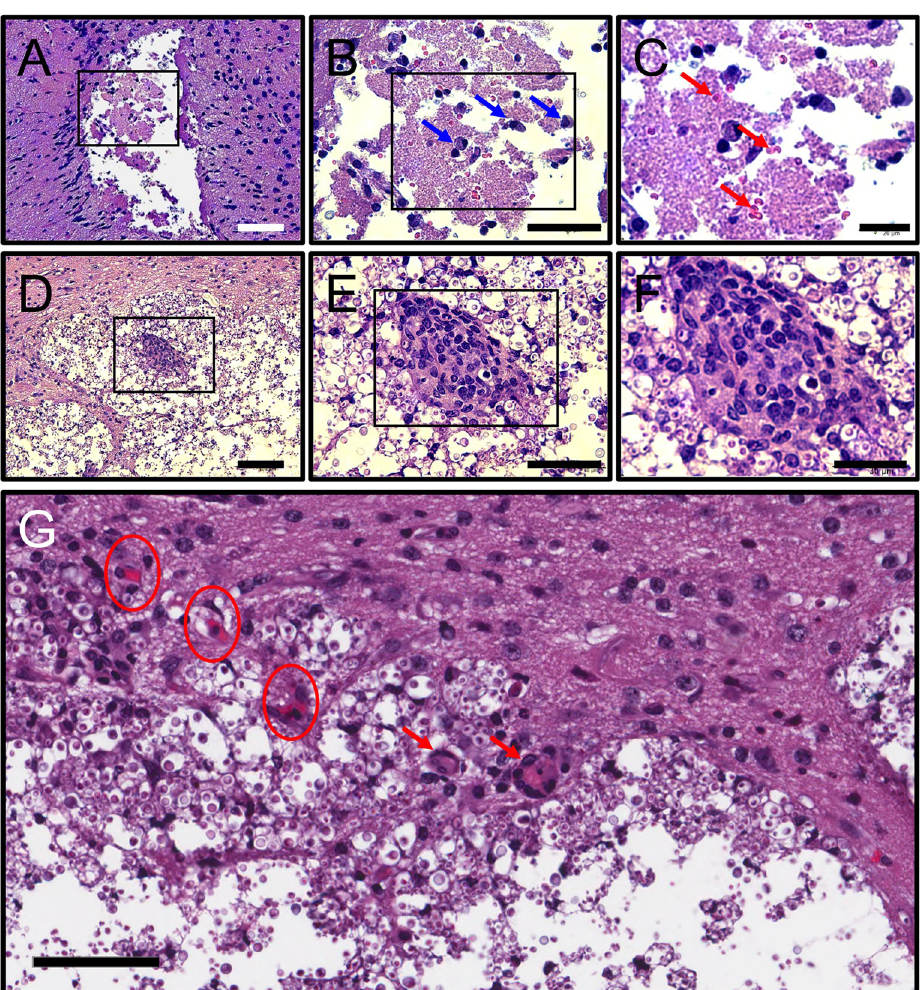
Fig 11. C57BL/6 mice infected with C . neoformans i.c. develop ischemic necrosis. H&E staining of the frontal cortex showing (A) necrosis of the gray matter , (B) accumulation of gitter cells (blue arrows in magnified rectangle) with foamy cytoplasms from engulfing necrotic tissue, and (C) microinfarctions (red arrows point to pleiomorphic or distorted erythrocytes). Scale bars: (A) 100 μ m, (B) 50 μ m, and (C) 20 μ m. (D-F) C . neoformans lesion or cryptococcoma in the striatum of mice show foreign body giant cells (black rectangle) surrounded by fungal cells and numerous phagocytic cells with vacuolated cytoplasm. Scale bars: (A) 100 μ m, (B) 90 μ m, and (C) 30 μ m. (G) Damage of cerebral capillaries (encircled areas) and microthrombus in the striatum of infected mice. Langhans giant cells are depicted by red arrows indicating poorly formed granulomas in striatal tissue. Scale bar: 60 μ m. Five mice per infection route were evaluated to confirm all the histopathological observations reported in these